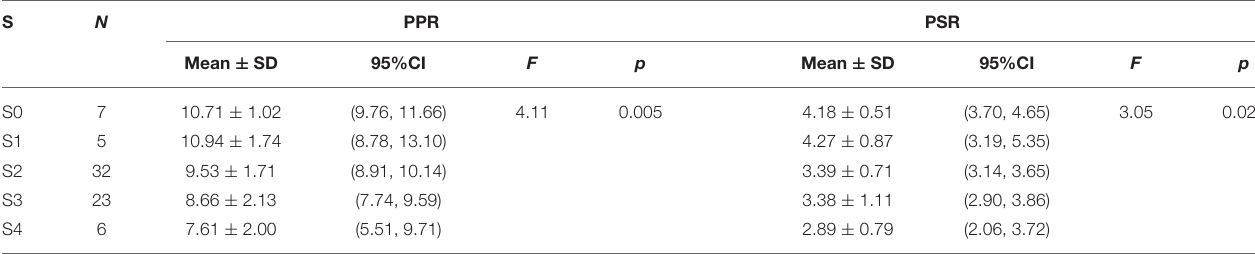
TABLE 4 | PPR and PSR in advanced liver fibrosis among HBV-infected patients with HBeAg-negativity and a normal ALT